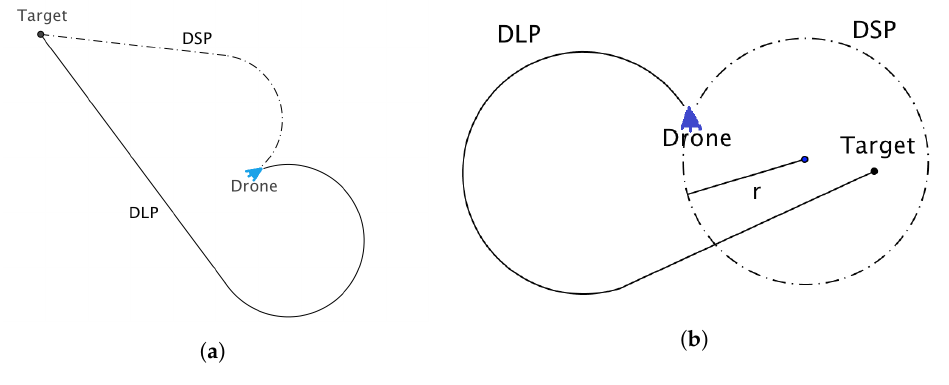
Figure 3. ( a ) Dubins shortest and longest paths (DSP and DLP, respectively) where the target lies to the left of the path of the drone; ( b ) DSP and DLP where the target lies to the right of the path of the drone. In ‘Multiple UAV Coalitions for a Search and Prosecute Mission’ by Manathara et al., the estimated